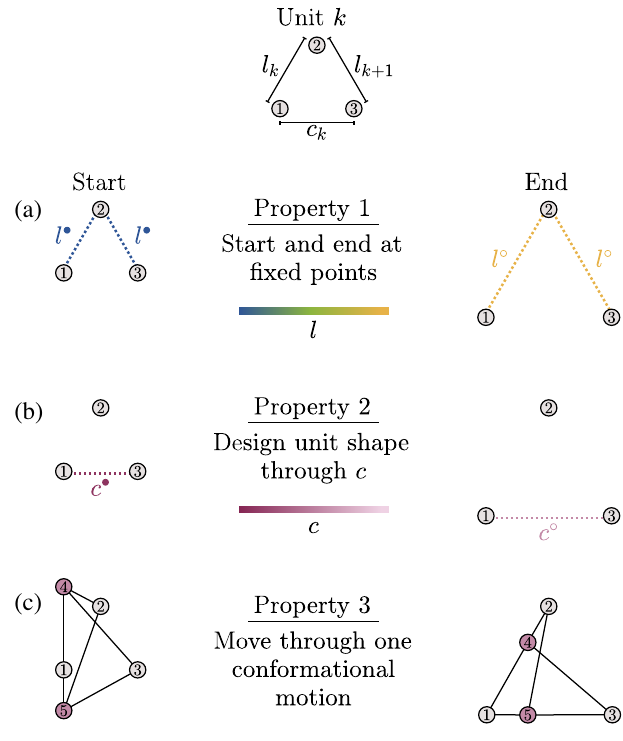
FIG. 6. Properties of unit design. We show a drawing of a unit with three nodes, 1, 2, and 3, with length l k between nodes 1 and 2, length l k between nodes 2 and 3, and length c k between þ 1 nodes 1 and 3. We seek to design units (a) that start and end at fixed points where l k ¼ l k ¼ l (cid:129) and l k ¼ l k ¼ l ∘ are valid þ 1 þ 1 conformations, (b) whose start and end geometry can be pro- grammed to start at c (cid:129) and end at c ∘ , and (c) that can transition from the start to the end shape with one conformational